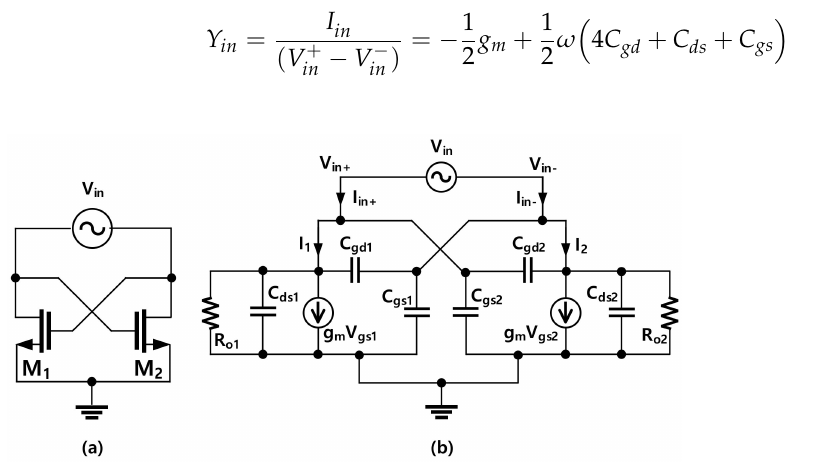
Figure 3. ( a ) A cross-coupled pair of NMOS with a port; ( b ) the simplified small-signal model of the circuit in ( a